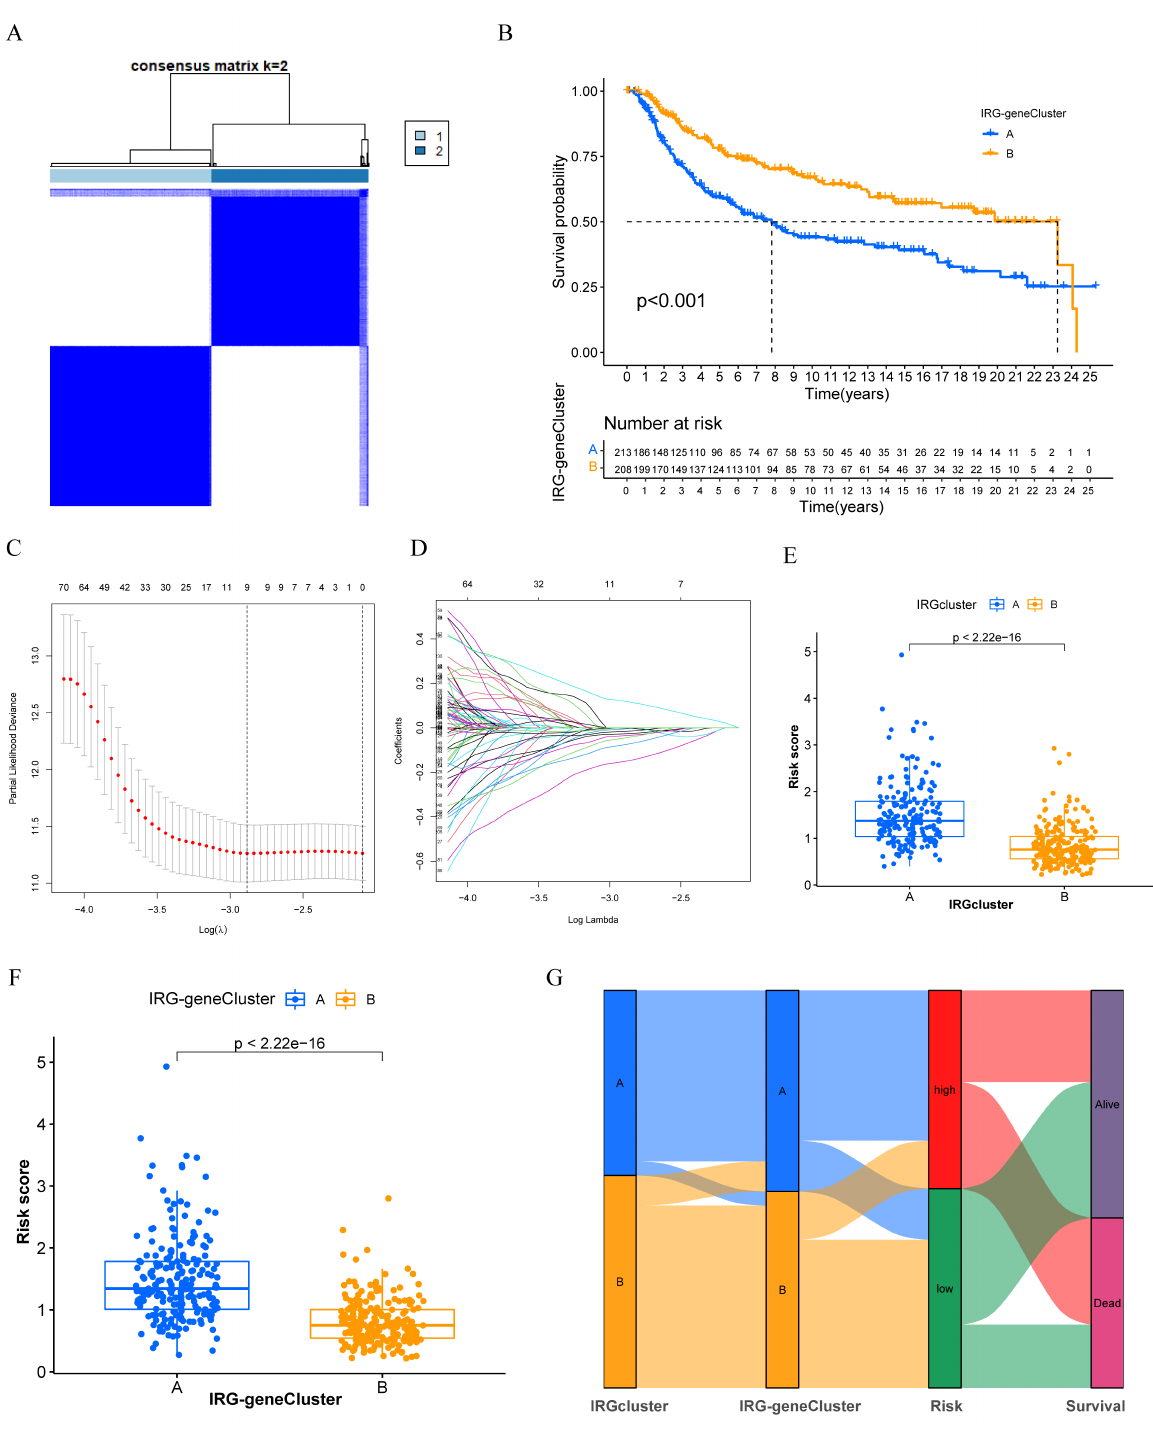
Figure 4. Construction of IRGs geneCluster and the immune-related gene panel (IRGP). ( A ) The identification of IRG-geneCluster by consensus clustering matrix for k = 2. ( B ) Survival curves of the IRG-geneCluster were plotted by the Kaplan–Meier plotter. The numbers of patients in IRG- geneCluster A and IRG-geneCluster B subtypes are 213 and 208. ( C ) Elucidation for LASSO coefficient profiles of prognostic IRGs. ( D ) The least absolute shrinkage was performed and construction of selection operator (LASSO) regression model. ( E ) The correlation between IRGs risk score and IRGs subtypes. ( F ) The correlation between IRGs risk score and IRG-geneCluster. ( G ) Alluvial diagram of IRGs clusters in groups with different IRG-geneCluster, IRGs risk score, and